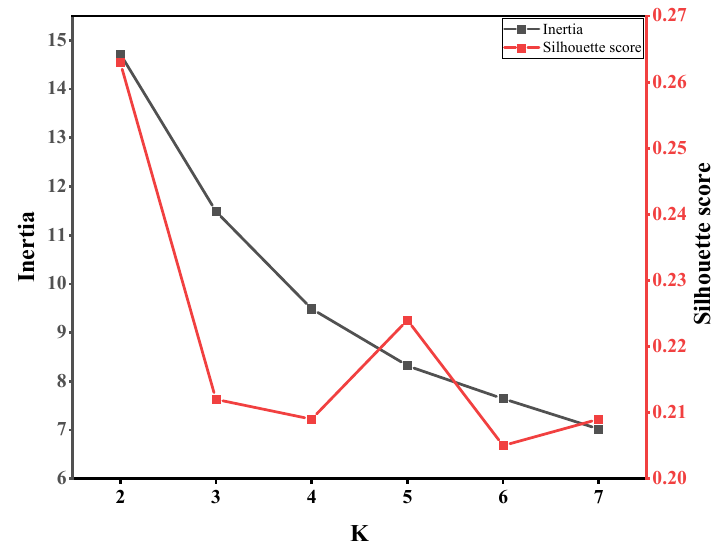
Figure 9. Inertia and silhouette score of models when K changes from 2 to 7. Table 4. Cluster centers of the behavior in operating the mechanical ventilation